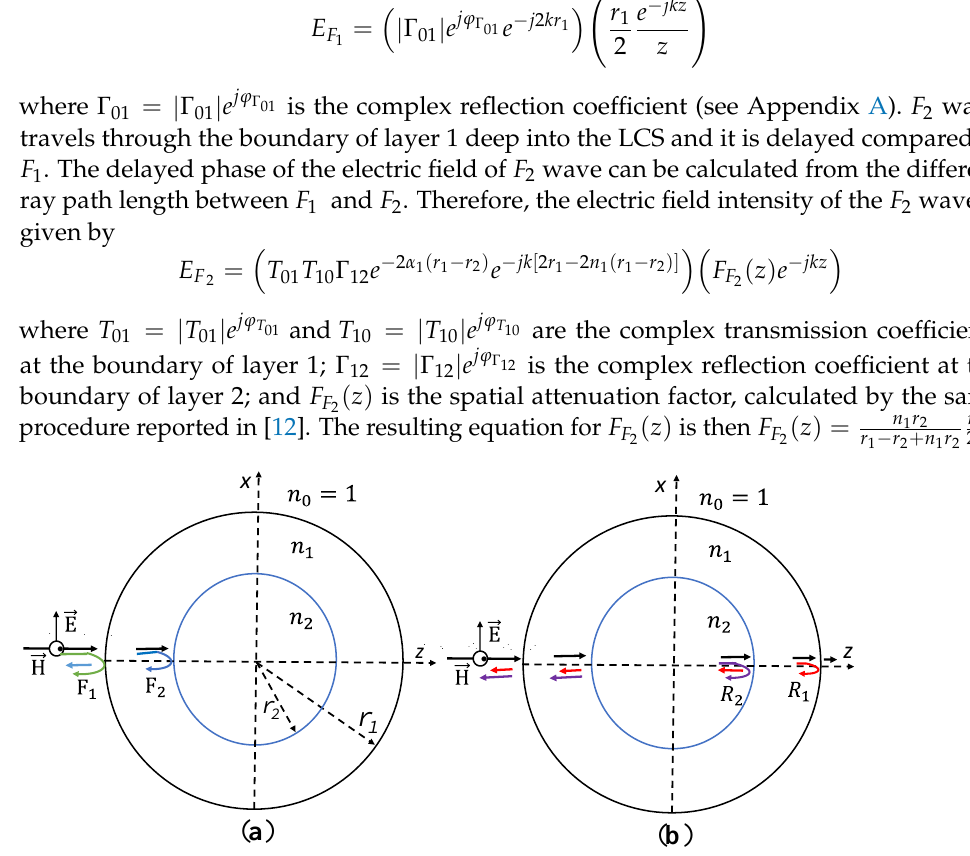
Figure 2. Backscattered waves from a normal incident wave on two-layer dielectric sphere: ( a ) Front axial return wave; ( b ) Rear axial single bounce return wave.